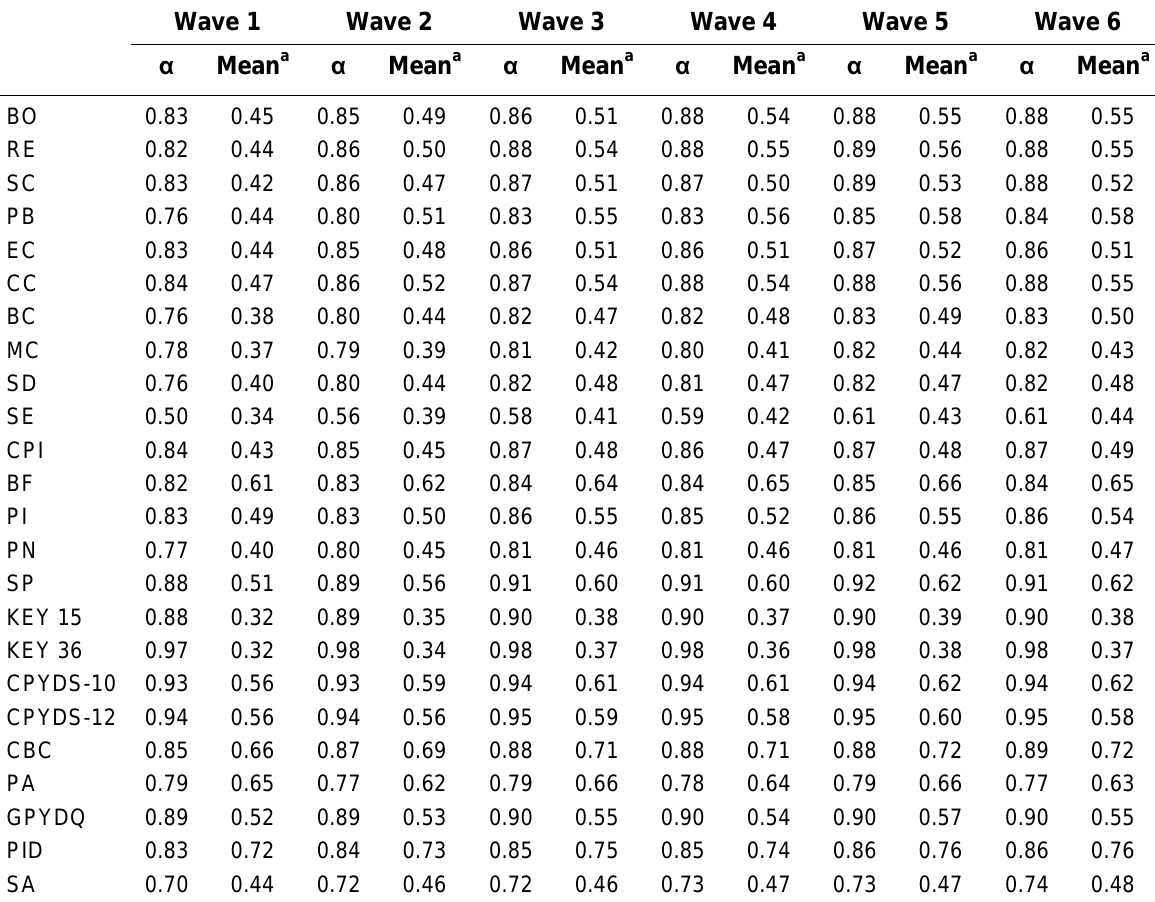
Internal Consistency and Mean Interitem Correlations for All Indicators of the